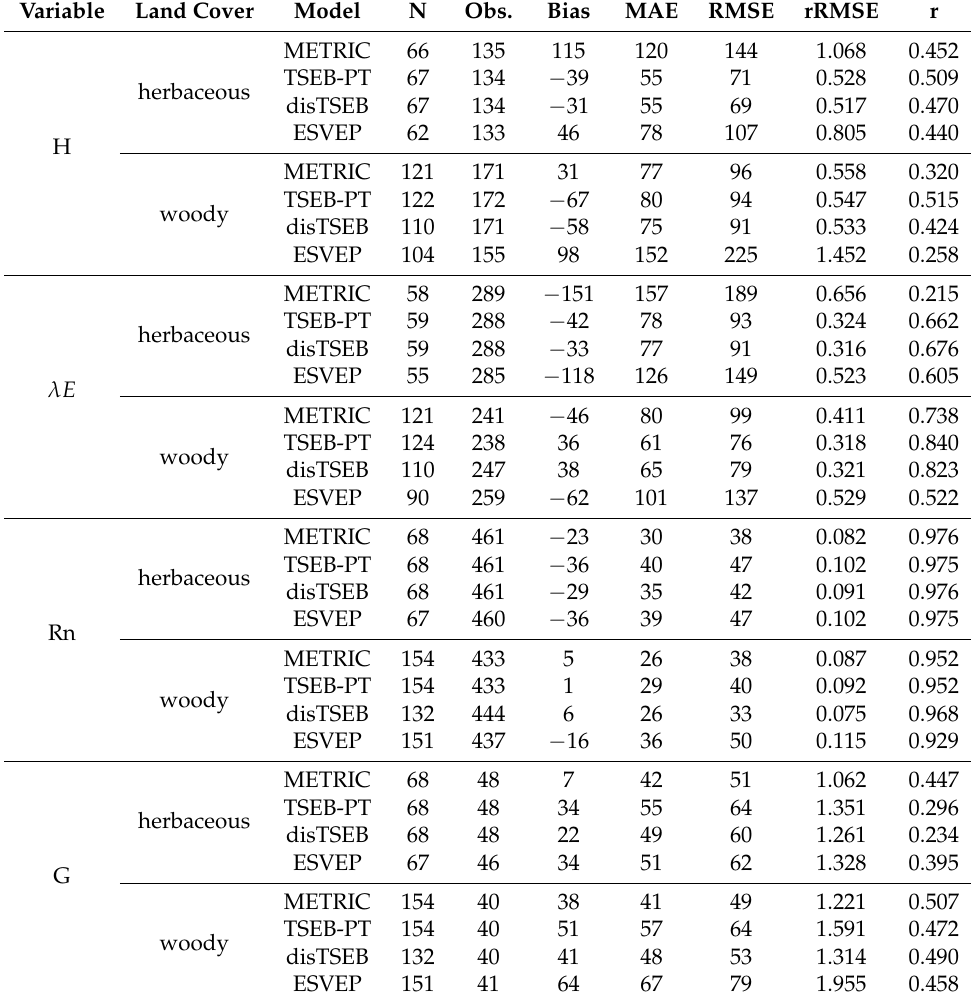
Table 6. Crop type dependent errors for METRIC, TSEB and ESVEP modelled fluxes using Decision Tree sharpened temperatures. N, number of valid cases; Obs.; mean of observed values (W m − 2 ); bias, mean difference between predicted and observed (W m − 2 ); MAE, Mean Absolute Error (W m − 2 ),